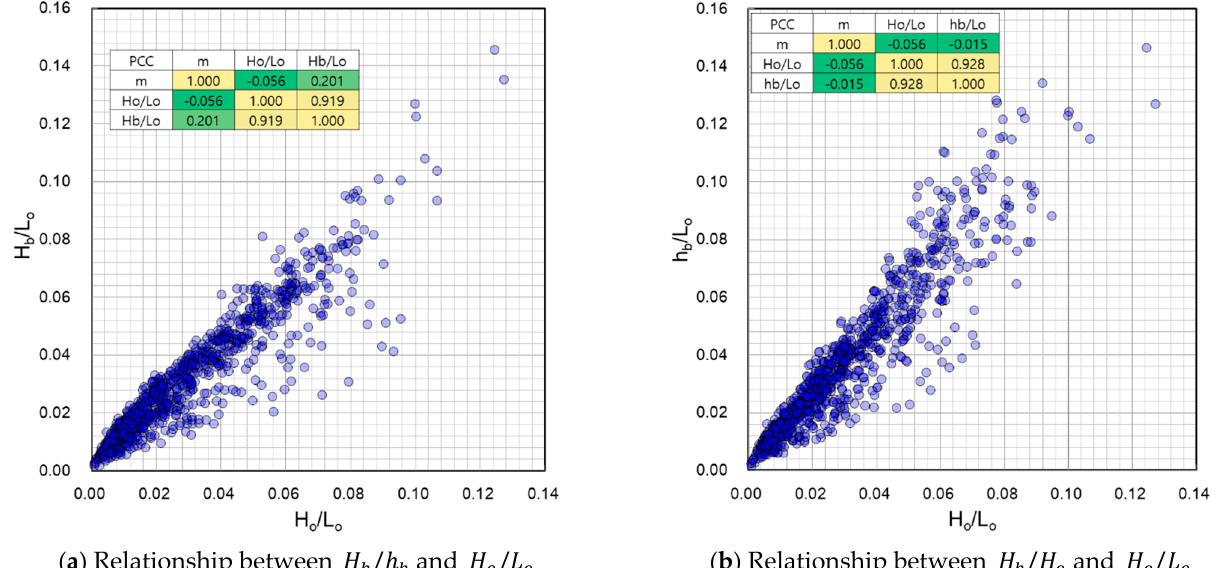
Figure 3. Relationship between breaker indices: ( a ) H b / L o , ( b ) h b / L o and deep-water wave steepness H o / L o by historical laboratory experiments.